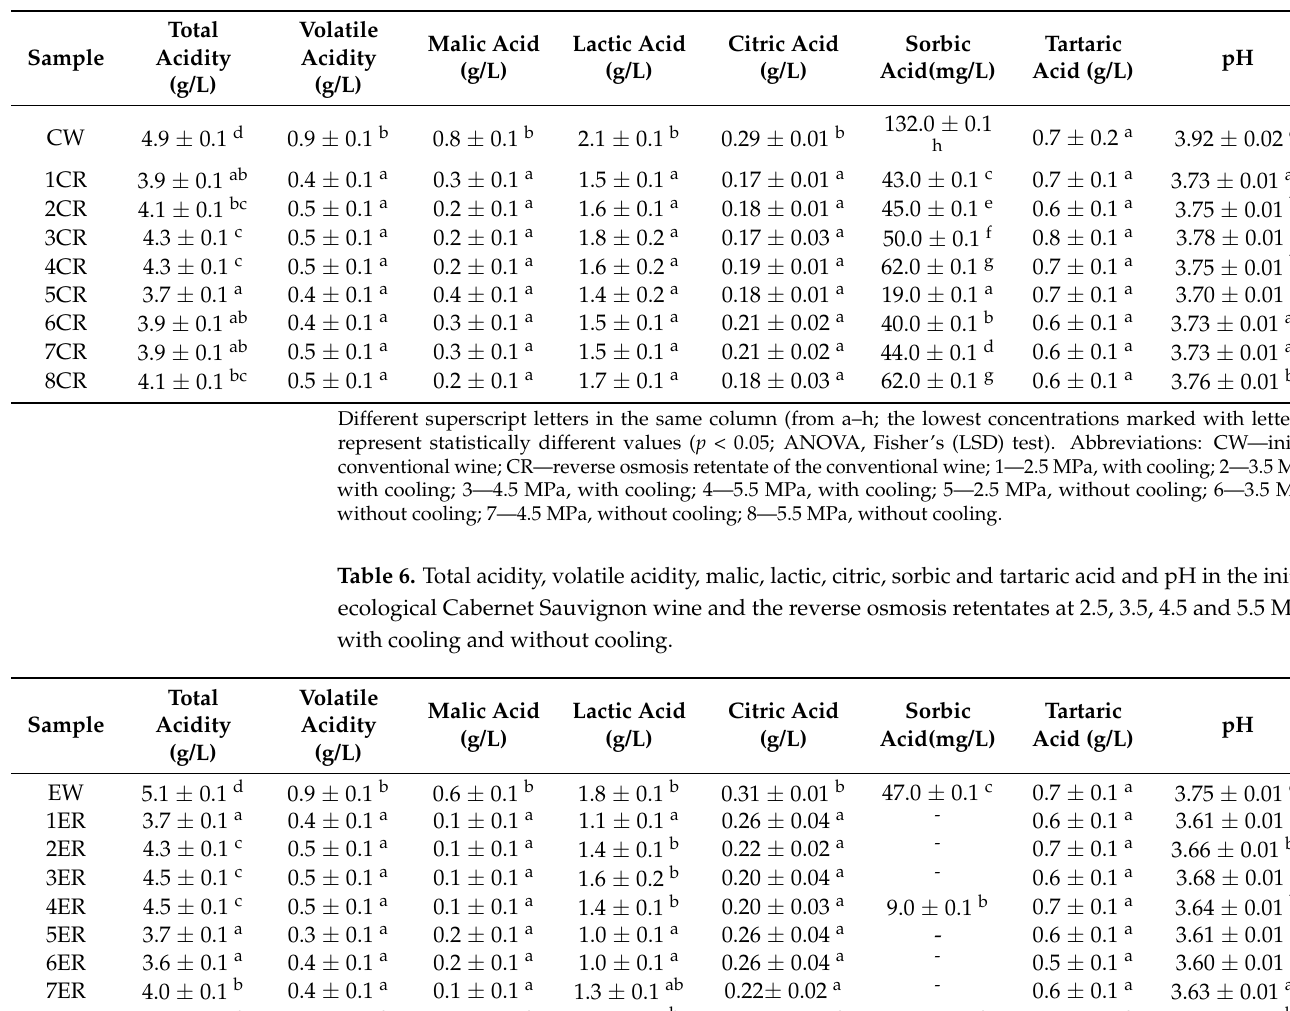
Table 5. Total acidity, volatile acidity, malic, lactic, citric, sorbic and tartaric acid and pH in the initial conventional Cabernet Sauvignon wine and the reverse osmosis retentates at 2.5, 3.5, 4.5 and 5.5 MPa, with cooling and without cooling.